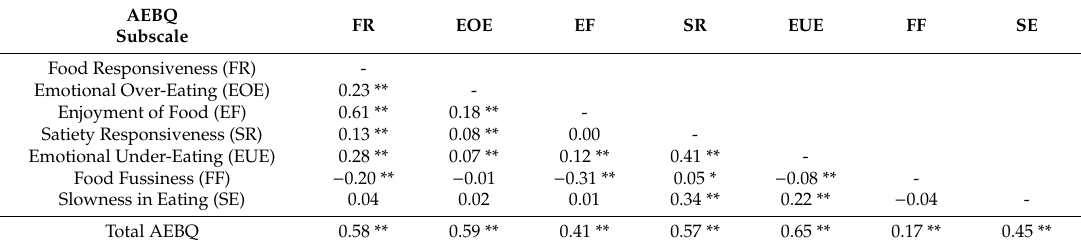
Table 7. Correlations between Adult Eating Behavior Questionnaire (AEBQ) subscales in Polish adolescents ( n =